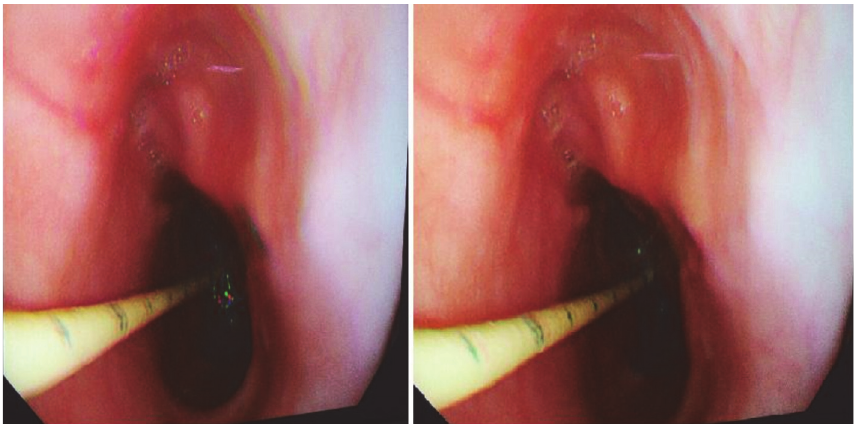
Figure 4: Follow-up endoscopic view of resolved haematoma-nasojejunal tube shown in